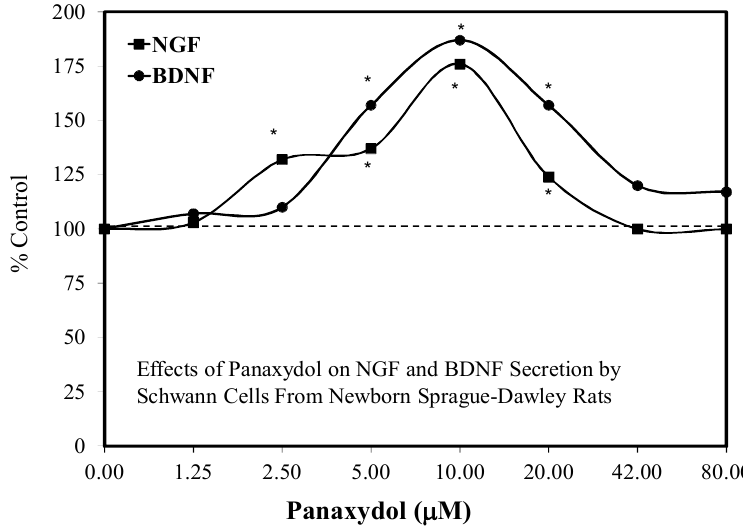
Figure 34. Effects of panaxydol on nerve growth factor (NGF) and brain-derived neurotrophic factor (BDNF) secretion by Schwann cells from newborn Sprague–Dawley rats (Source: [74]). Each * represent statistical significance for a data point.